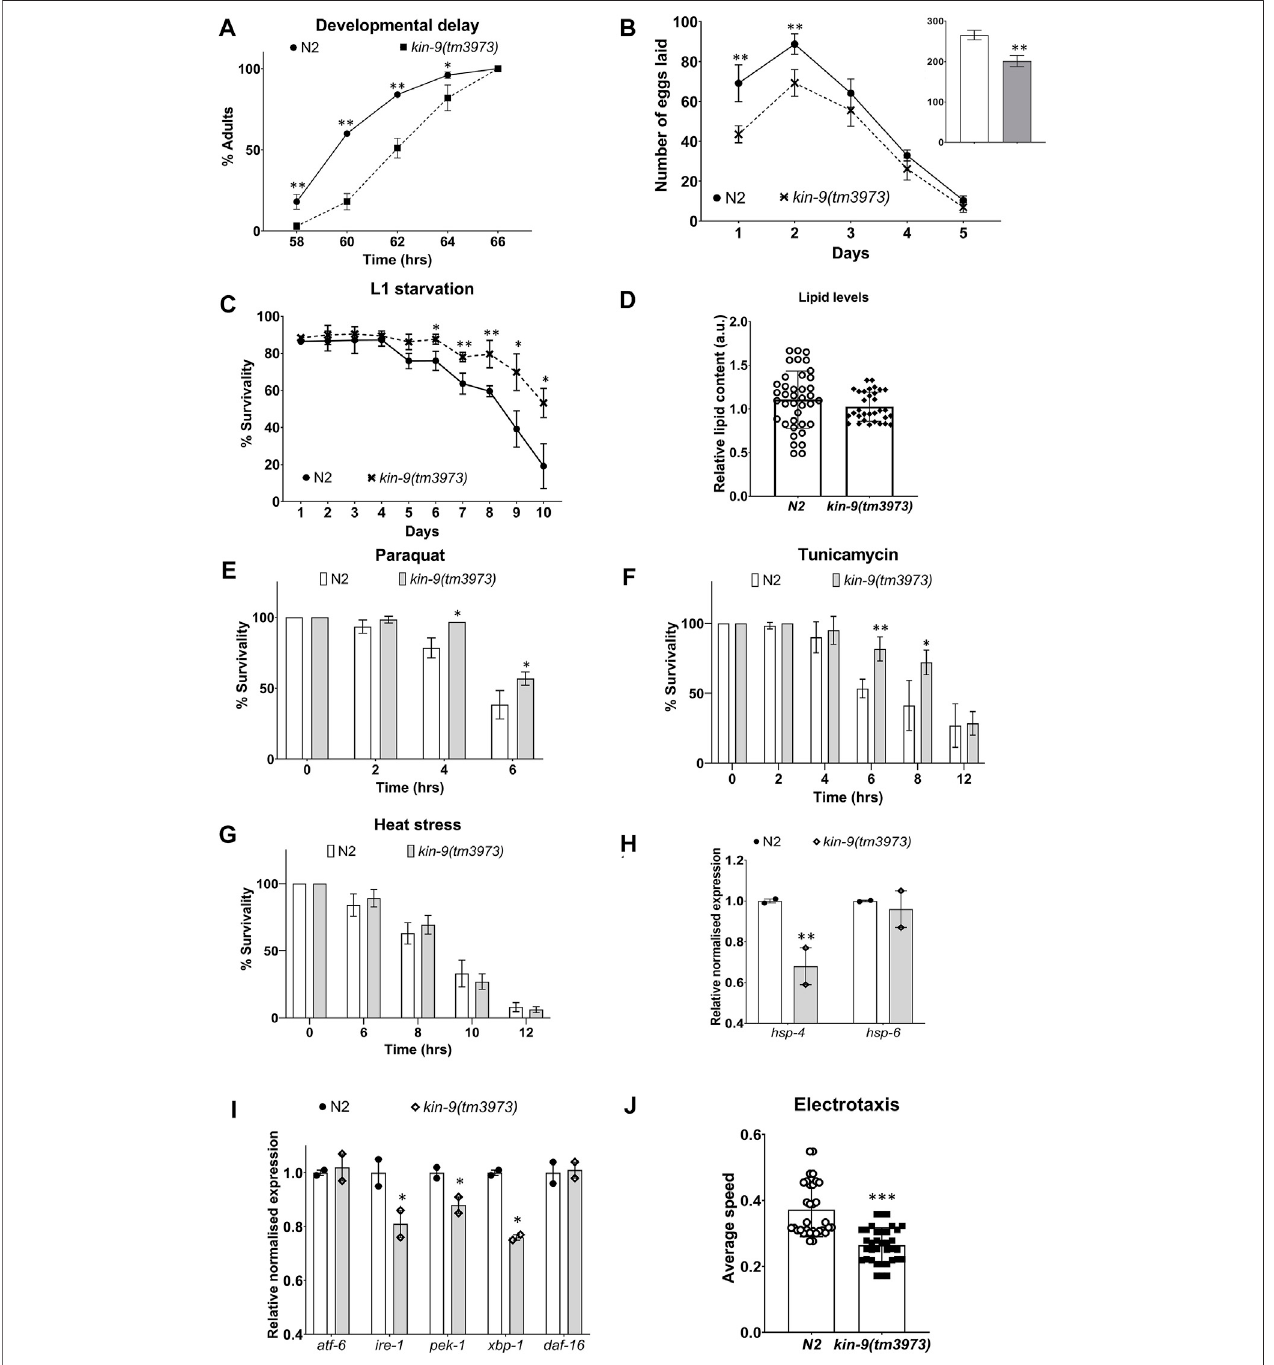
FIGURE 2 | kin-9 mutants exhibit resistance to heat and chemical-induced stress. (A) Graph showing the time taken to reach adulthood. (B) Line graph showing the number of eggs laid by kin-9 mutants compared to N2. Smaller bar graph showing the total number of eggs laid (N2- clear bar; kin-9(tm3973) grey bar). (C) Survival graph of kin-9(tm3973) L1 worms upon starvation compared toN2. (D) Quanti fi cation ofneutral lipids using Oil Red O staining. (E,F) Bar graph showing the survivability of kin-9 mutants compared to N2 following paraquat (200 mM) and tunicamycin (25 ng/ μ L) over a period of 6 and 12hrs respectively. (G) Survivability of kin-9 mutantscompared toN2at 35 ° Cover aperiod of12hrs. (H,I) qPCR analysisofdaf-16 genesin kin-9(tm3973) adults compared toN2. Datain (H – I) represent the mean of two replicates and error bars the standard error of means. Signi fi cance was calculated using Bio-Rad software (one-way ANOVA). (J) Electrotaxis analysis of day-1 kin-9(tm3973) adults. (A – G,I) Data represent the mean of two replicates (n > 40 animals in each replicate) and error bars represent the standard deviation. Statistical analyses were done using multiple unpaired t -tests and signi fi cant differences are indicated by stars (*): * ( p < 0.05), ** ( p < 0.01), *** ( p < 0.001).